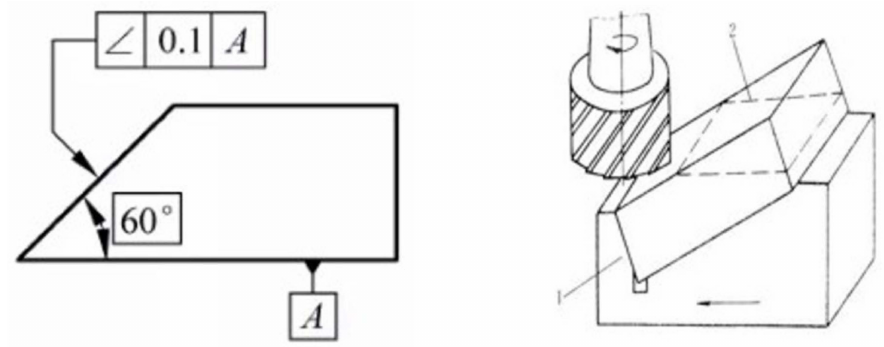
Figure 6. Example 1; 1 and 2 refer to fixture and workpiece, respectively. Table 1. PQRVs and IPQRV of Example 1 and the distribution of each. B C iht C N ∗ ( 0,0.003 ) N ( 60,0.006 ) B − C iht * N denotes normal distribution. p ≤ 0.001.